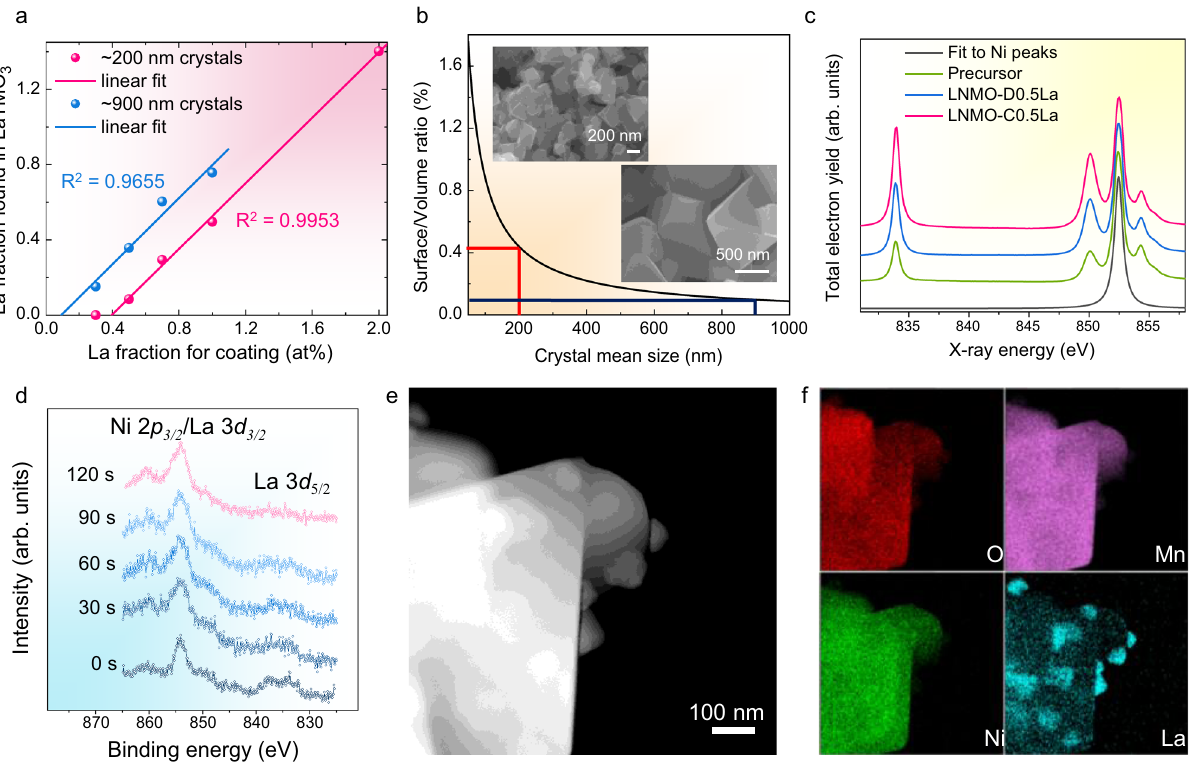
Fig. 3 Surface enrichment of La on the LNMO samples. a Integrated normalized intensities of LaTMO 3 peaks as a function of relative La concentration, normalized on the LNMO (311) peak. The fi tting errors ( R 2 ) are 0.9953 and 0.9655 for ~200 and ~900nm LNMO crystals. b Surface to volume ratio as a function of the size of the LNMO octahedra. The surface adsorption fraction depends on the size of the LNMO octahedra shows a shift to higher values for smaller crystals (inset shows the SEM images). Coloured lines indicate the points on this curve as extracted from the data in ( a ). c NEXAFS spectra of La and Ni signals showing increasing surface presence of La for La doping precursor, LNMO-D0.5La, and LNMO-C0.5La (the integrated intensity is normalized to the Ni peak). d XPS spectra of LNMO-C0.5La etched by Ar + etching as a function of etching time. e HAADF-STEM image of a typical BLNMO-C1.0La. f Corresponding elemental mappings of ( e ).